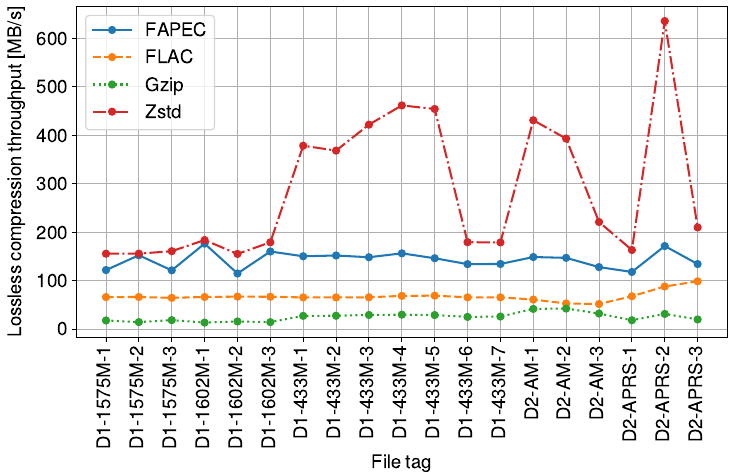
Figure 2. Lossless compression throughput of the RF signals.